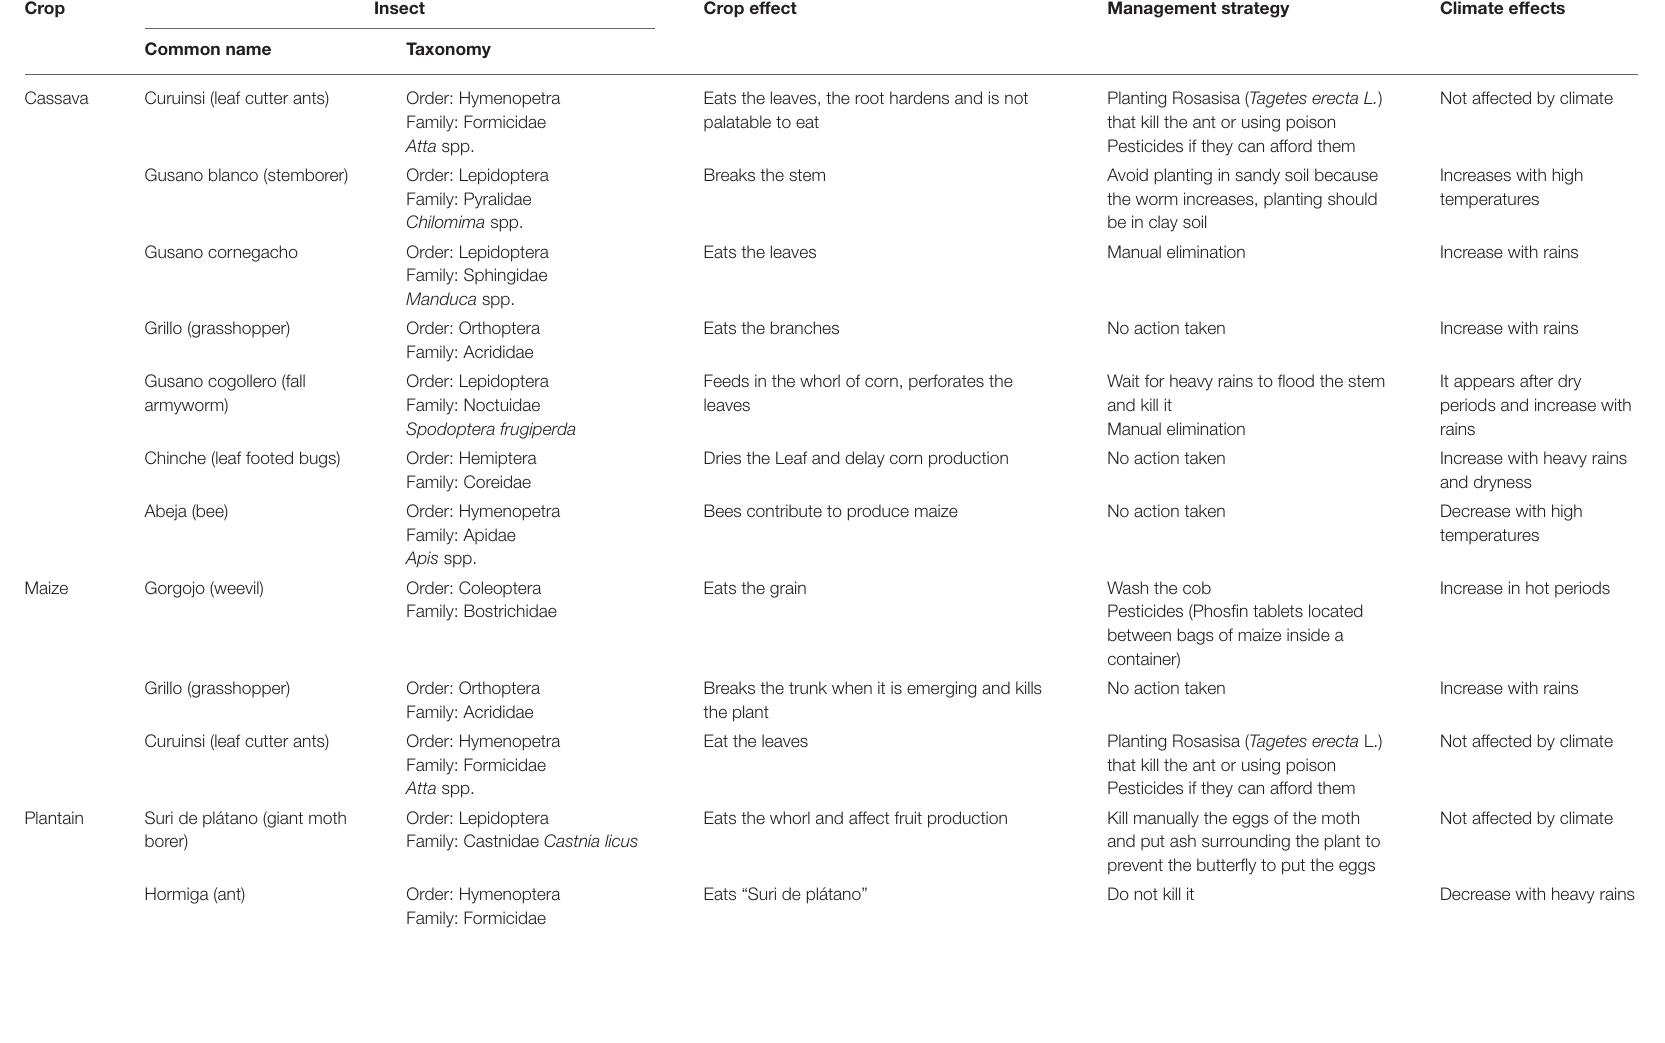
TABLE 5 | Practical knowledge of common management strategies associated with entomofauna among men.